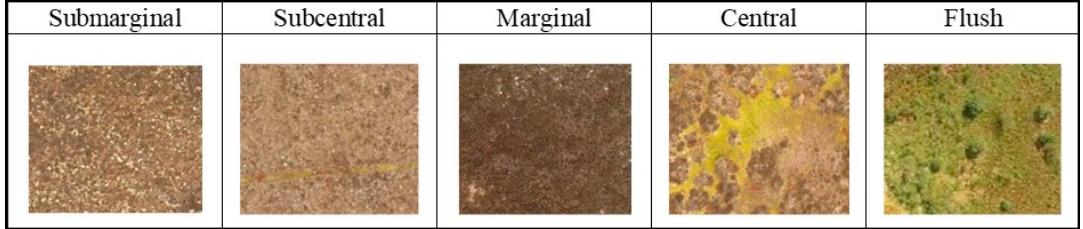
Figure 2. Ecotopes in Clara bog. Drone images, April 2019.